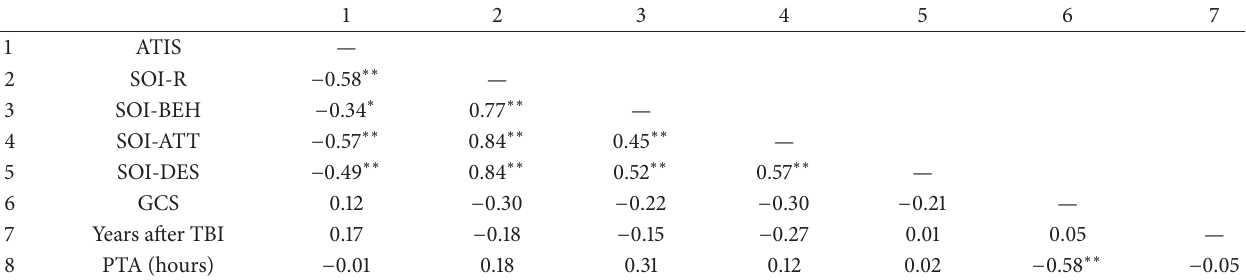
Table 4: Correlation matrix between infidelity, sociosexuality, and brain injury